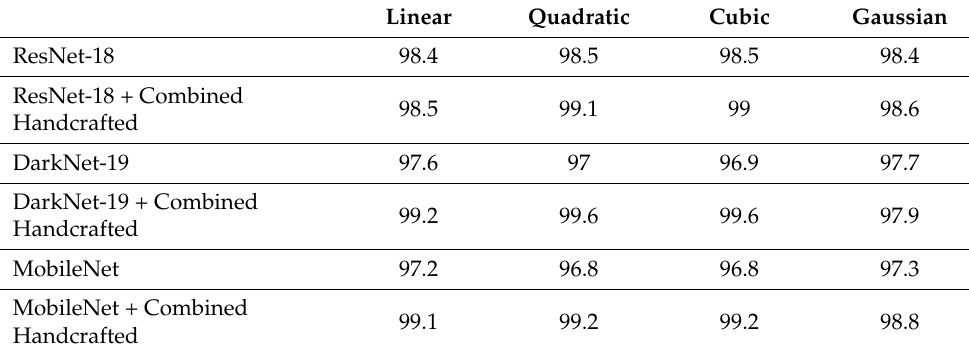
Table 2. The diagnostic accuracy (%) of the SVM classifiers trained with independent DL Feature sets and concatenated with the combined handcrafted features set from multiple domains. Linear Quadratic Cubic Gaussian